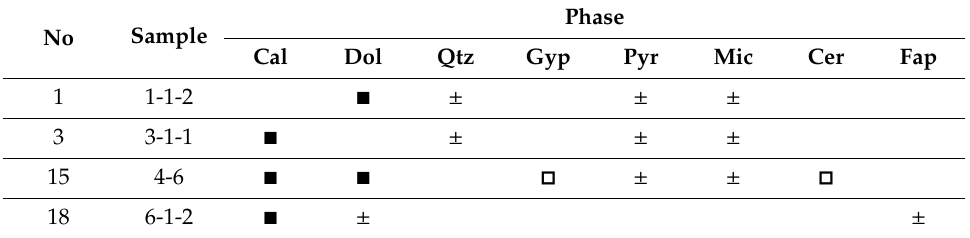
Table 2. Mineralogy of the studied anthraconite samples (data obtained by microprobe